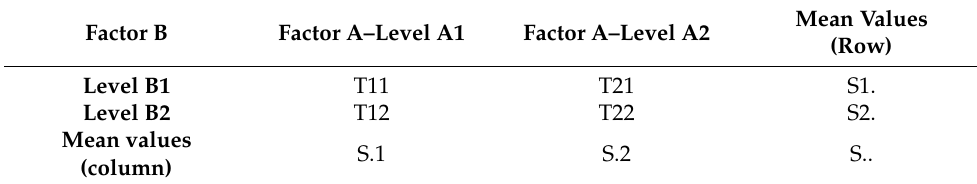
Mean Values (Row)